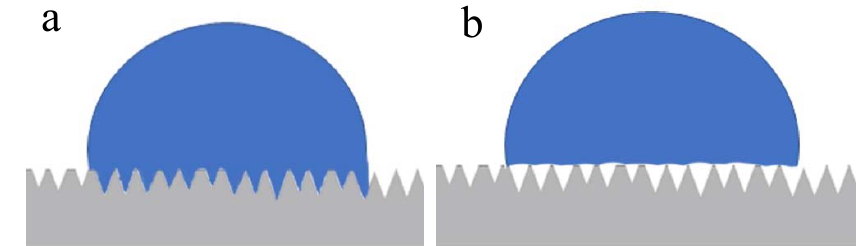
Figure 8. Illustrative scheme of the wettability behavior of a water drop on a rough surface. ( a ) Wenzel’s law of wetting, where the water is in close contact with the surface and ( b ) Cassie’s law of wetting, where air is trapped between parts of the surface and the drop.